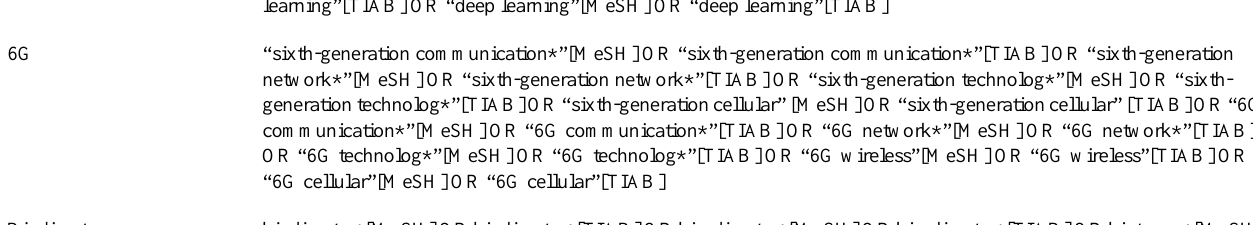
Search termTheme